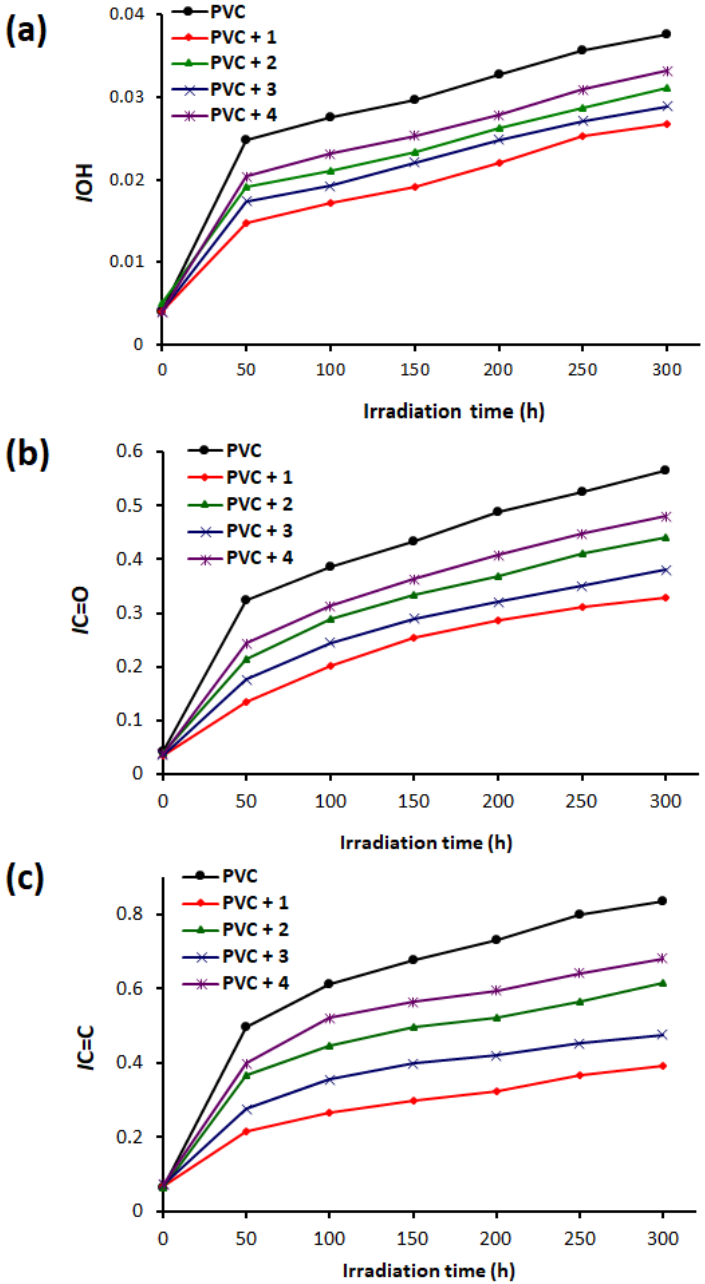
Figure 4. Changes in ( a ): I OH, ( b ): I C=O, and ( c ): I C=C for PVC films.